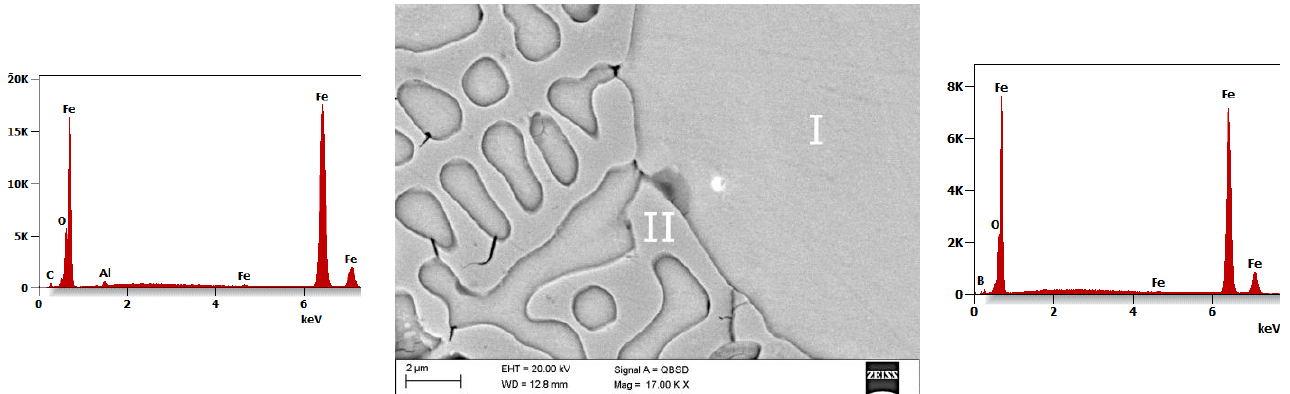
Figure 2. SEM image of the ingot structure in the center and the chemical composition of phase I and II La_1 ( a ), La_2 ( b ), La_3 ( c ).